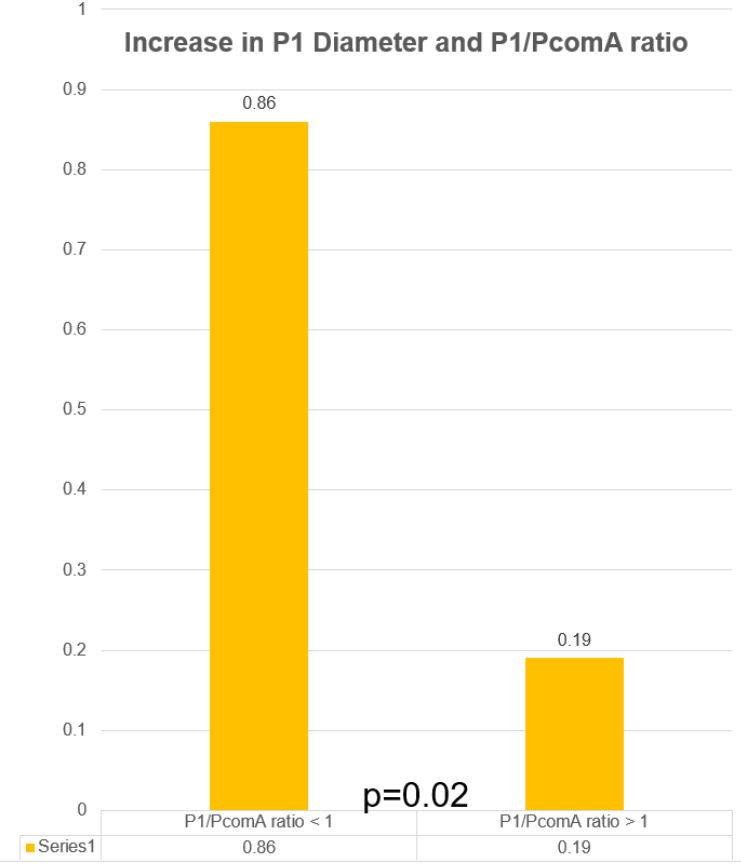
Figure 3. Change in P1 diameter in relation to P1/PcomA ratio.